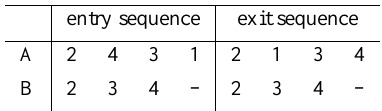
Fig. 13. Diagram in upper panel shows Cluster configuration with the orbit direction, boundary structure, and dusk-tailward motion in- ferred from timing analysis. The lower panel illustrates the inferred structure of the boundary interaction with Cluster. We propose that the bursty signature is due to the Cluster orbit skimming the bound- ary between the LLBL/magnetosheath and the BPS. Table 2. Entry and exit sequence of spacecraft for features A and B from Figs. 11 and 12